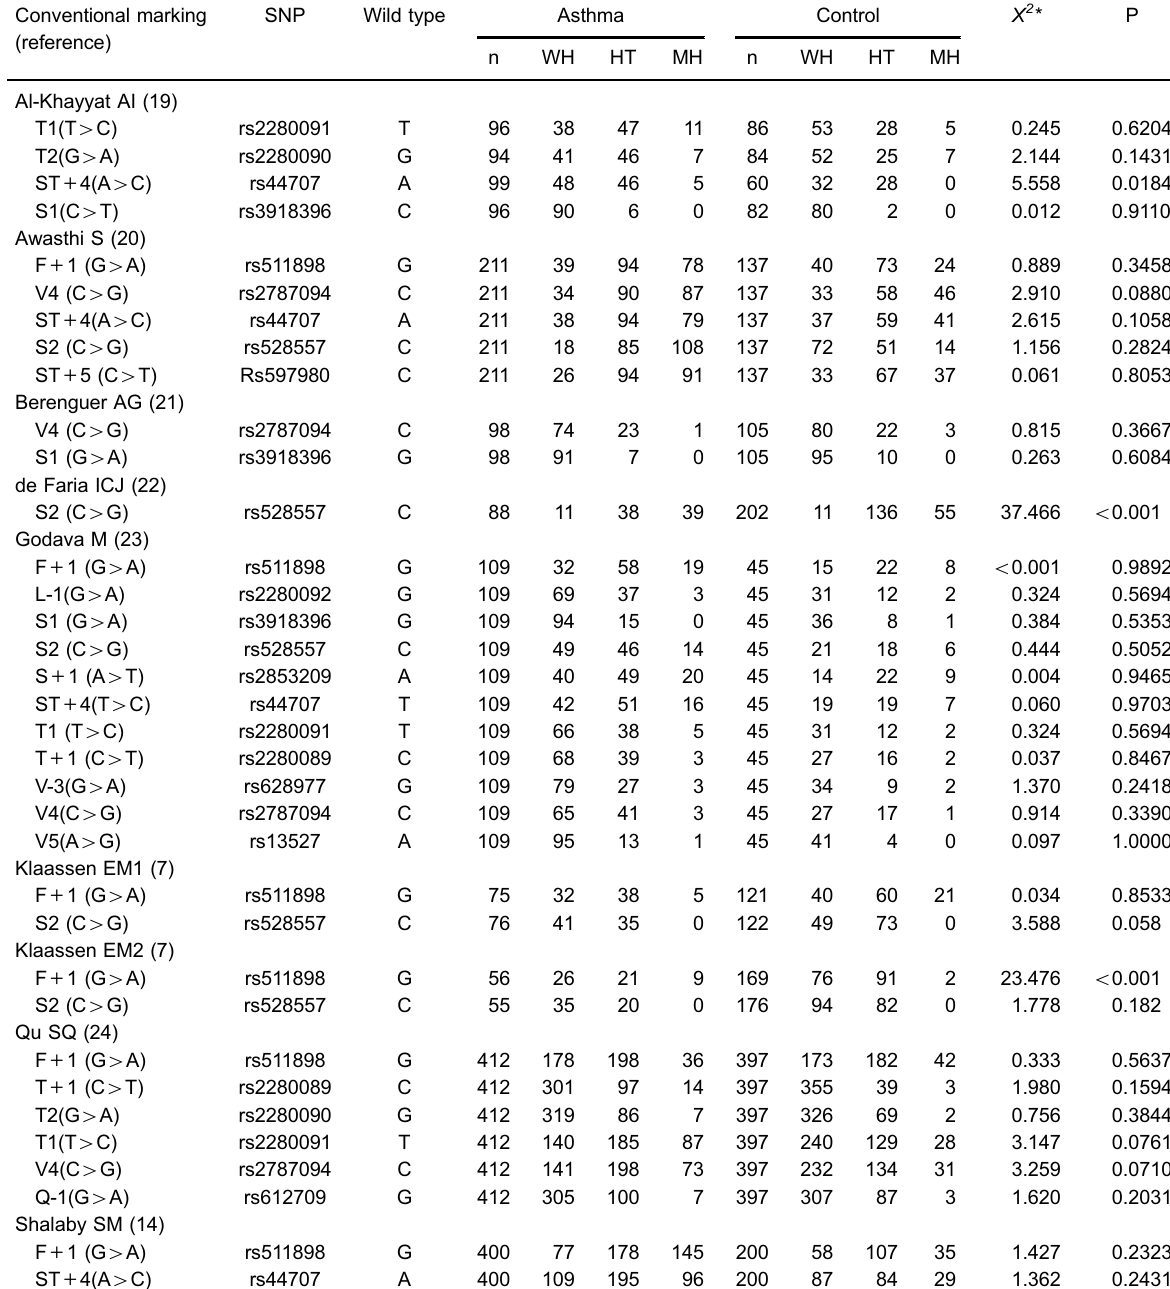
Table 2. Distribution of ADAM33